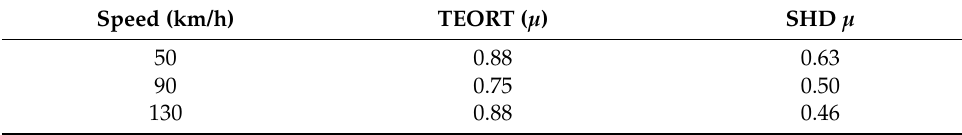
Table 6. Type-2 fuzzy analysis for TEORT and SHD.